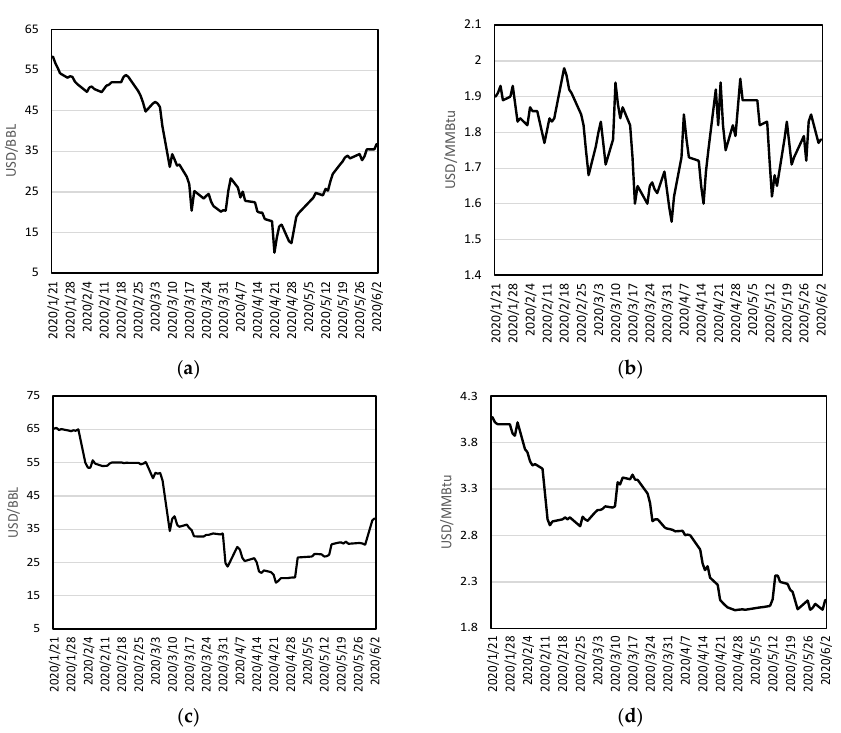
Figure 5. The US and Japanese Oil and natural gas prices, ( a ) WTI, ( b ) HH, ( c ) Dubai, ( d ) JKM.